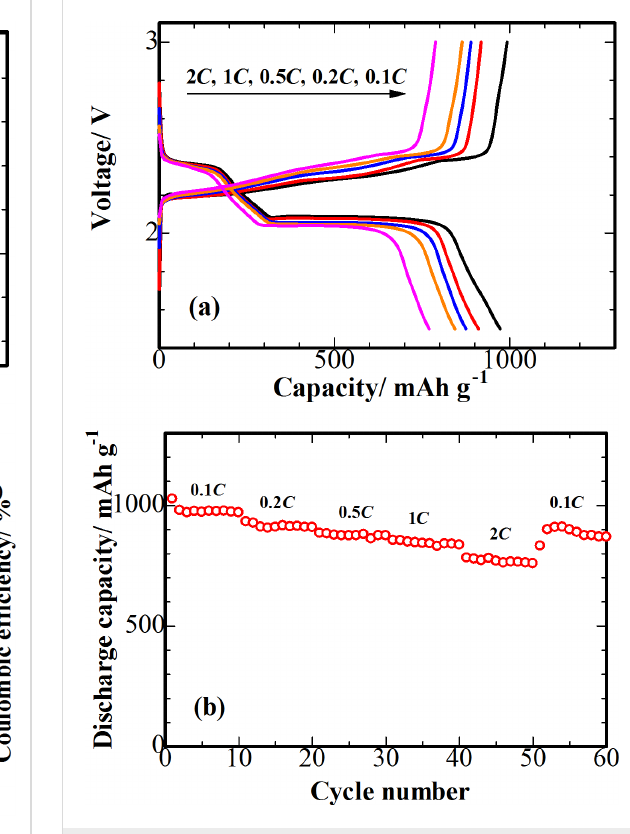
Figure 6: (a) CV measurement of the S-3D-RGO@MWCNT cathode (1st, 50th, 100th, 150th and 200th cycle) at 1 C ; (b) cycling perfor- mance of the S-3D-RGO@MWCNT cathode at 1 C for 200 cycles.